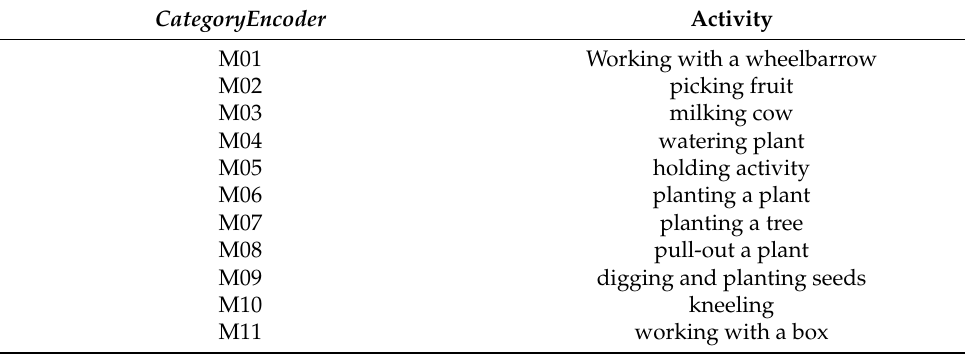
Table 1. CategoryEncoder for the Farming-Pack mocap